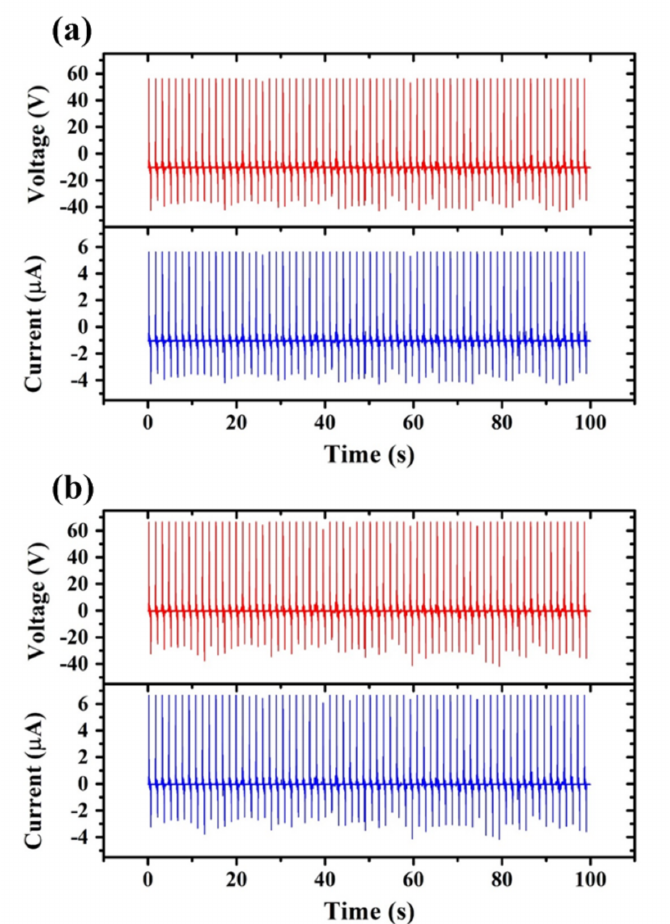
Figure 5. Output performance of TEGs assembled with: ( a ) loose and ( b ) tight unpatterned CT layers. The TEGs connected to an external load with a resistor of 10 M Ω .